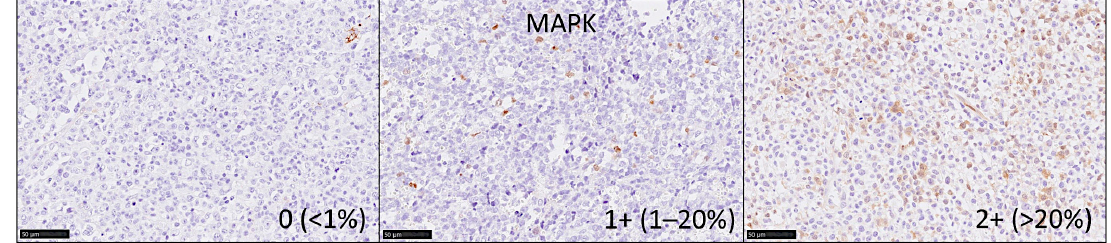
Figure 6. Immunohistochemistry for MAPK. The immunohistochemical signals were evaluated as an ordinal variable as 0 (no staining, <1%), 1 + (few scattered positive cells, 1–20%), or 2 + (abundant cells, >20%). Positive staining, brown color